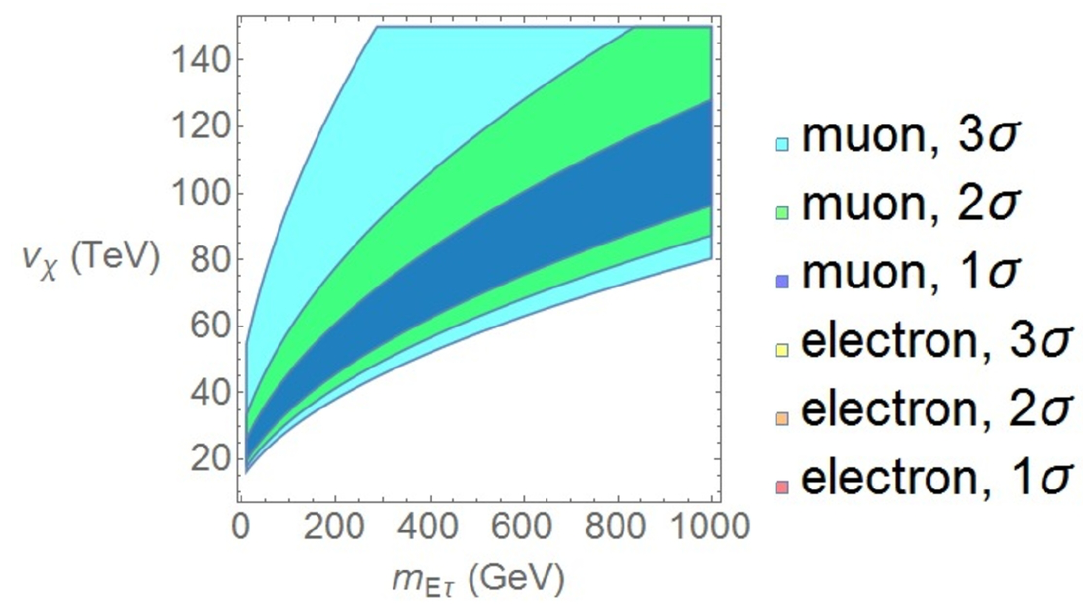
Figure 17 . Same as in (cid:12)gure 15 but now with m E